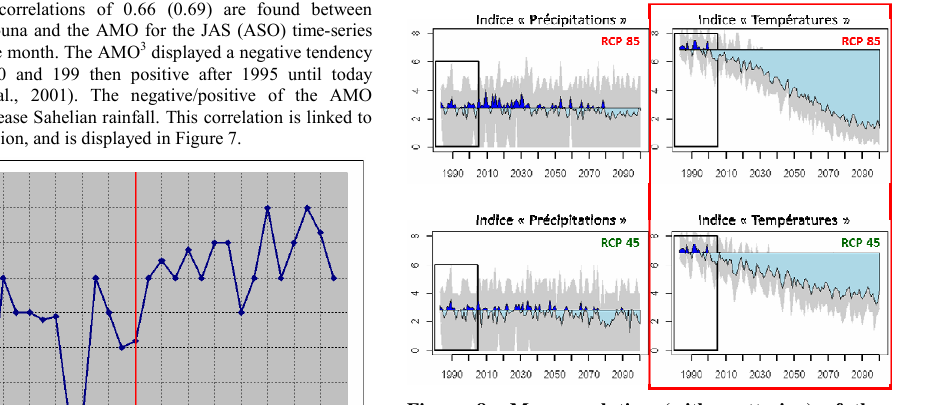
Figure 8 : Mean evolution (with scattering) of the yearly indices for temperature and rainfall favoring malaria diffusion from 1983until 2100 using the two Figure 7 : Index of favorable malaria conditions and climate scenario of RCP45 andRCP85. Post-2005, the rainfall in the Nouna region. The red line is for the evolution for RCP45, are at top, and RCP85 at AMO tendency change in 1995. bottom. The light blue shading are for period. Les parties blue/light blue are for periods above/below the mean computed during the 1983-2005 historical